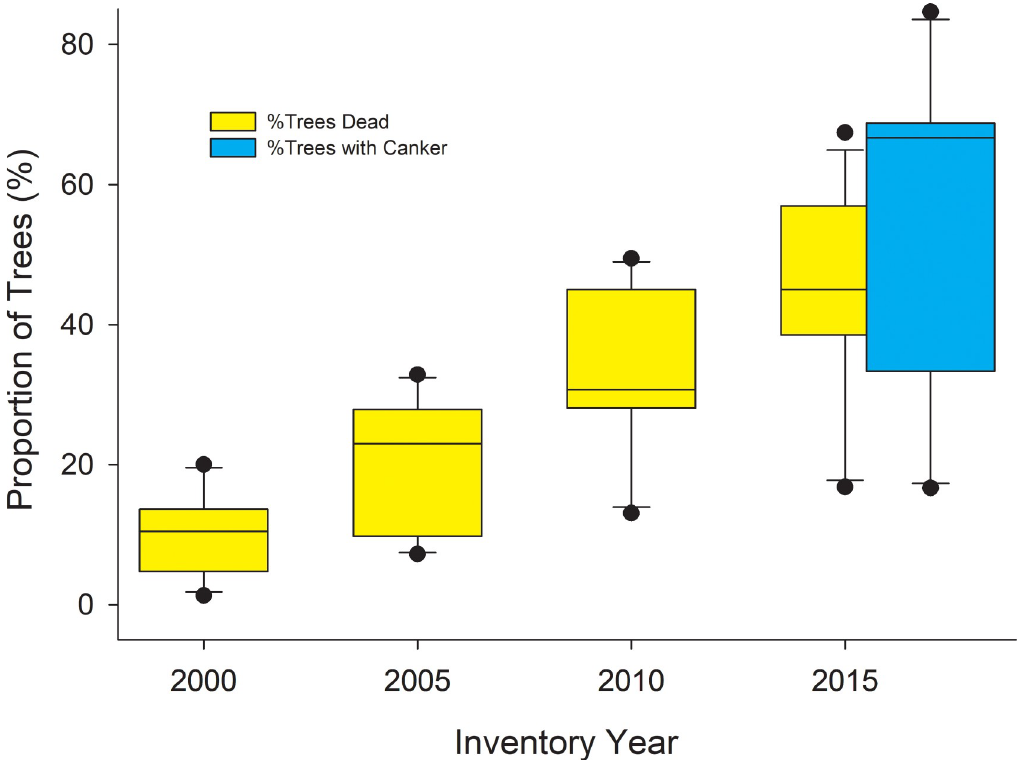
Fig 10. Box plots showing % of all aspen trees dead at select CAFI sites in 2000 and every 5 years thereafter. When plot inventory began in 1995, dead trees were not inventoried, but all live trees were tagged and those that subsequently died were inventoried on subsequent dates. The CAFI program included other sites in the inventory program from 1996–2013, but the 12 sites here represent the cohort of sites with the longest sampling history (other than 4 sites first inventoried in 1994 but not included here). Also shown are the proportion of trees with canker at these same sites that we inventoried in